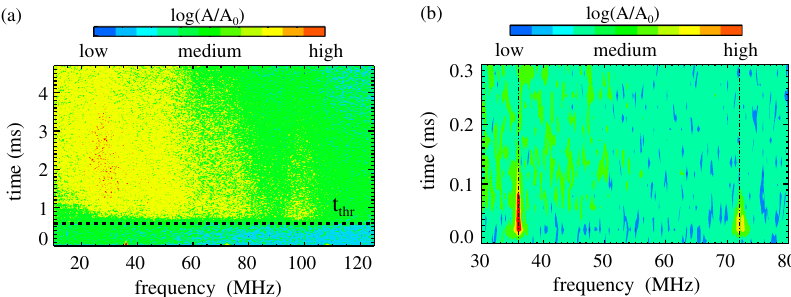
FIG. 8. Measured frequency spectrum after injection into the SIS. The dashed line in (a) indicates the time needed for the formation of the critical number of filaments t thr . In (b), one can observe the 36 MHz structure of the UNILAC microbunches and their higher harmonics.